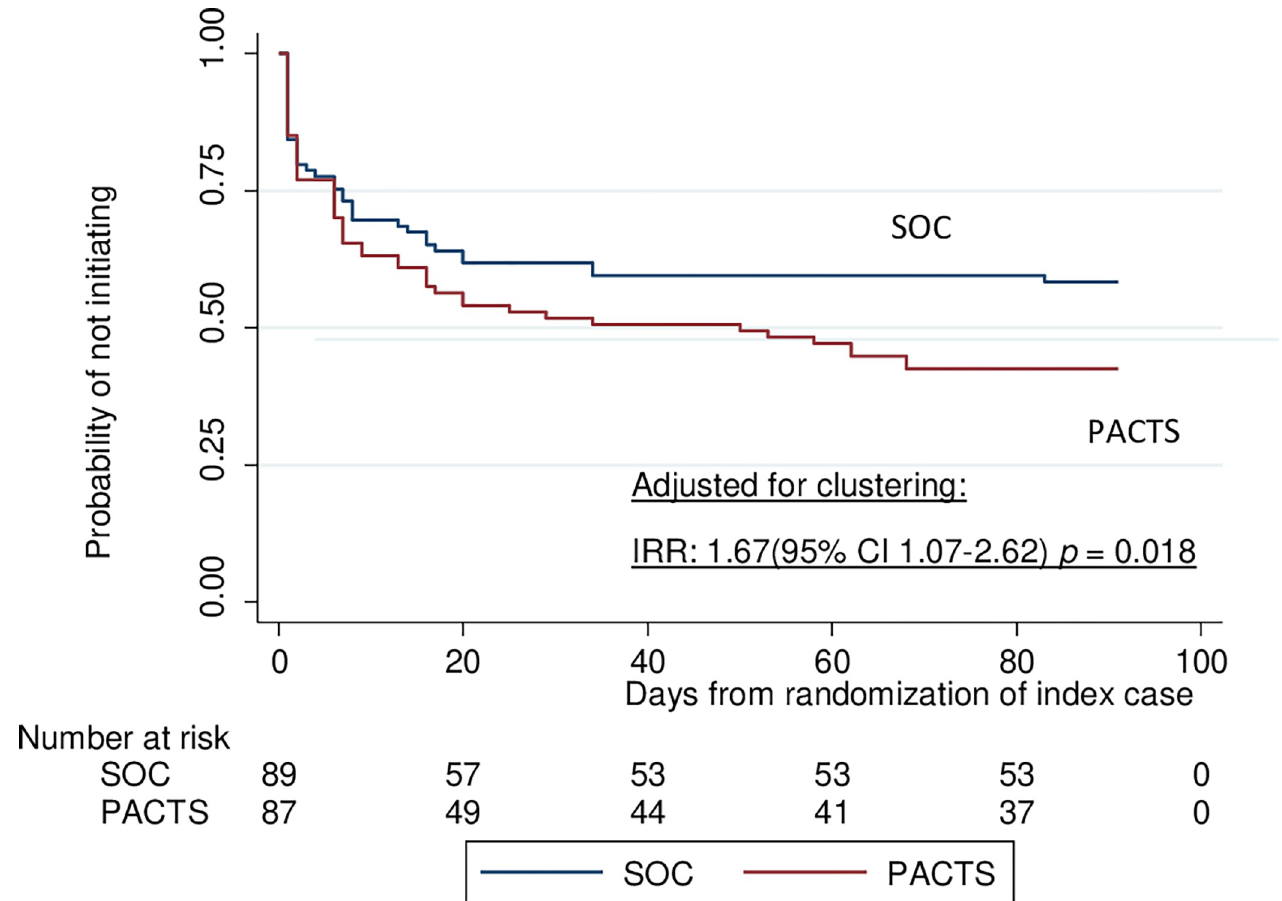
Fig 2. Probability of not initiating IPT by 3 months after index